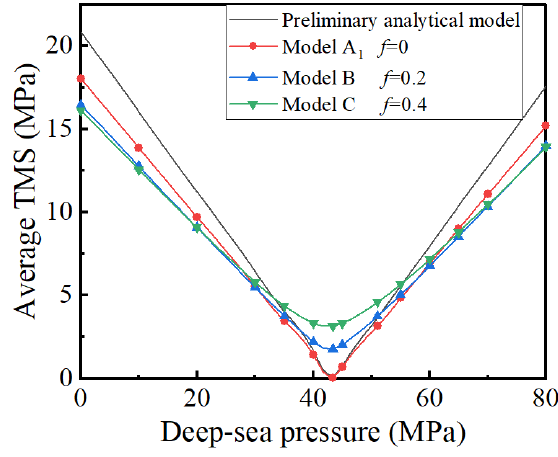
Figure 5. Average TMS of different copper fill factor variations with deep-sea pressure.